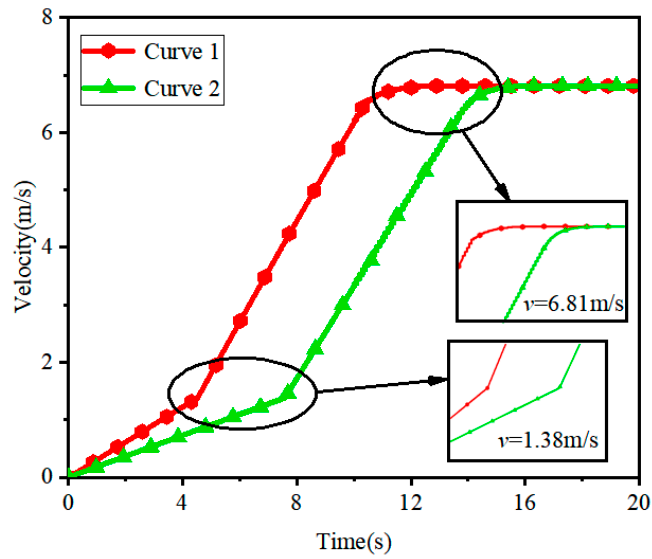
Figure 9. Diagram of the vehicle speed comparison.